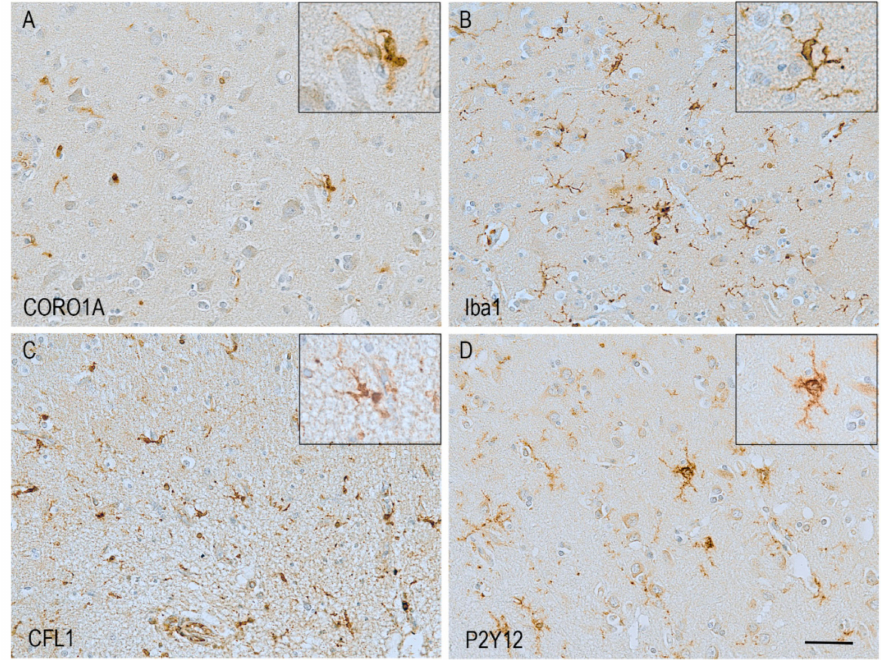
Figure 4. Examples of microglia identified using di ff erent motility-related microglial proteins. Haematoxylin counterstaining. A —CORO1A; B —Iba1; C —CFL1; D —P2Y12. Scale bar = 50 µ